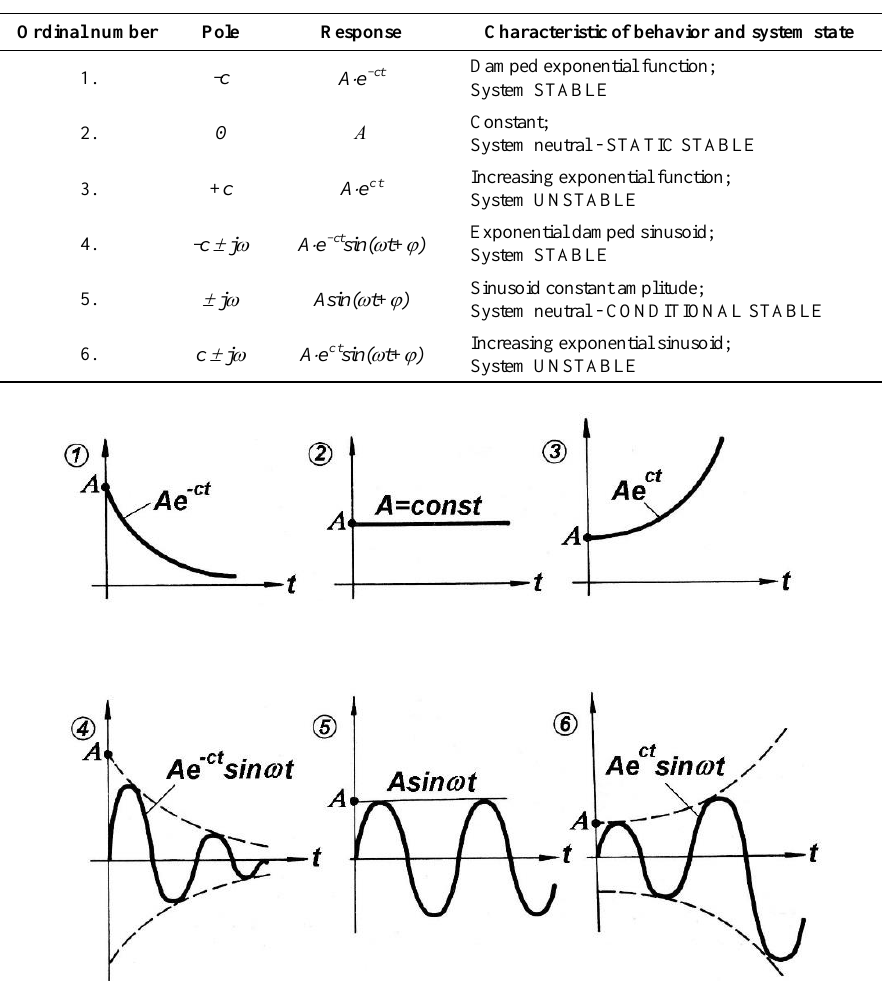
Figure 9. Possible position of the poles of transmissional function G(р) in the plane of complex variable p=c+j  . Table 2. Possible responses with characteristic behavior of the system.